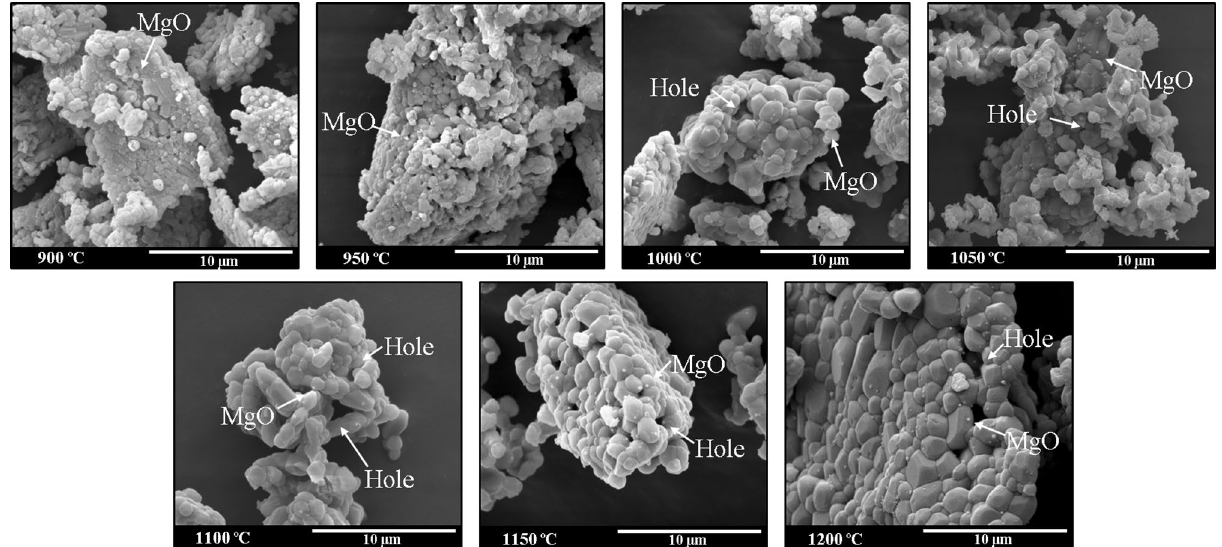
Figure 2. SEM images of the samples thermally treated at different calcination temperatures.